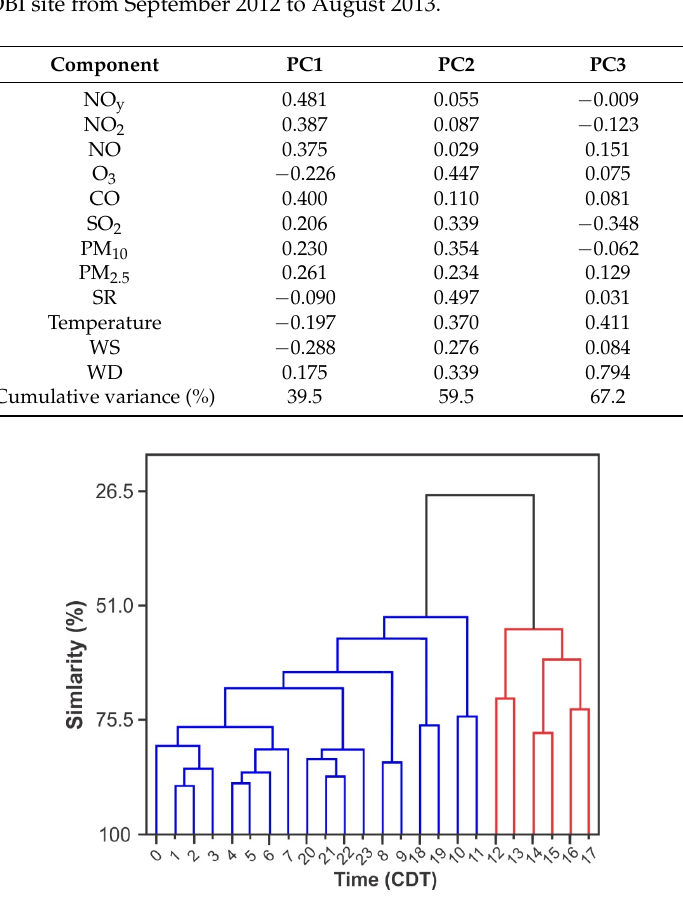
Figure 7. Dendrogram derived from the cluster analysis (CA) performed for 1-h averages of O 3 and SR data recorded at the OBI site from September 2012–August 2013. The red cluster shows the period of enhanced photochemical activity.